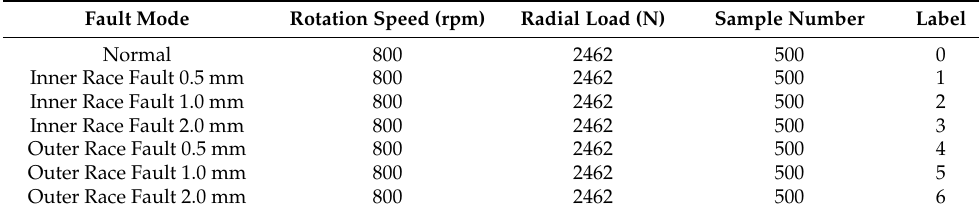
Table 6. Self-built dataset classification description.